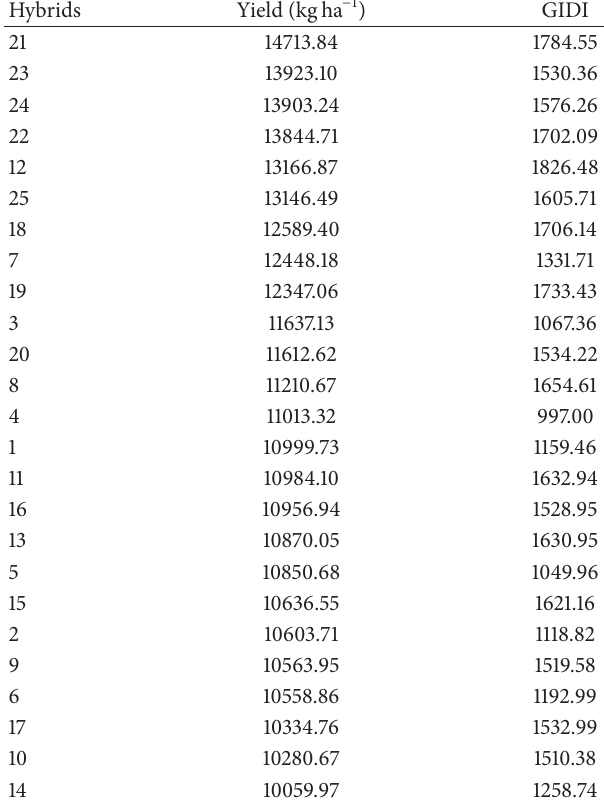
Table 1: Classification in decreasing order of the hybrids in regard to their mean grain yield (kg ha − 1 ) and their respective mean values of the GIDI considering the six assessment